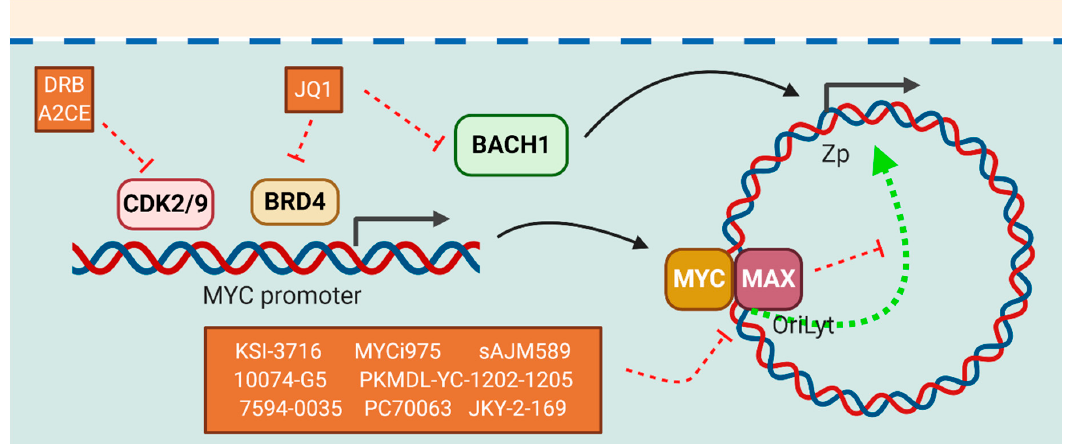
Figure 6. Relationship between EBV proteins and c-MYC and the modes of action of compounds with lytic induction potentials. MYC represses the activation of lytic cycle of EBV by binding to OriLyt on the EBV genome and suppresses its looping to the BZLF1 promoter. A2CE’s and DRB’s inhibition of CDK2/9, a transcription factor that regulates MYC expression, can suppress the expression of EBV latent proteins. Compounds that target the DNA binding domain of the MYC-MAX complex such as KSI-3716, MYCi975, and 7594-0035 may reactivate the lytic cycle of EBV.